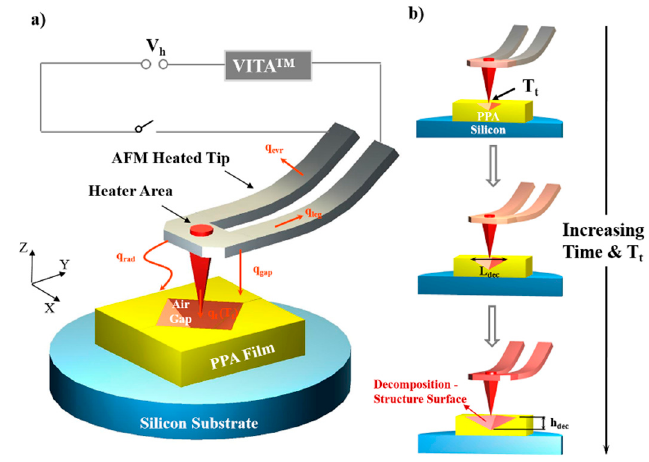
Figure 1. Schematic of an atomic force microscope (AFM) heated probe tip hovering above the polyphthalaldehyde (PPA) film on a silicon substrate to fabricate the pyramid decomposition structure (air gap). ( a ) The integrated heater area, lying above the tip free end, is electrified through the cantilever to heat the tip by controlling the VITA TM heating module. The resulting heat fluxes are represented by the orange arrows for the different modes of heat lost: through the cantilever legs ( q leg ) and tip ( q t ) by conduction, from the tip to environment ( q evr ) by conduction, from the tip to PPA film ( q gap ) by conduction, and the radiation ( q rad ). The decomposition of PPA film, which causes a pyramid air gap structure to form on its surface, is induced by q gap . ( b ) The cross-section plot of the sample underneath the heated cantilever (being mounted at an angle of ~12°) showing the dimension of the air gap structure changing with the increasing tip temperature and heating time. The horizontal and vertical sizes of the air gap structure are indicated by the two double-headed arrows, which are located on and perpendicular to the PPA surface and marked by L dec and h dec , respectively.